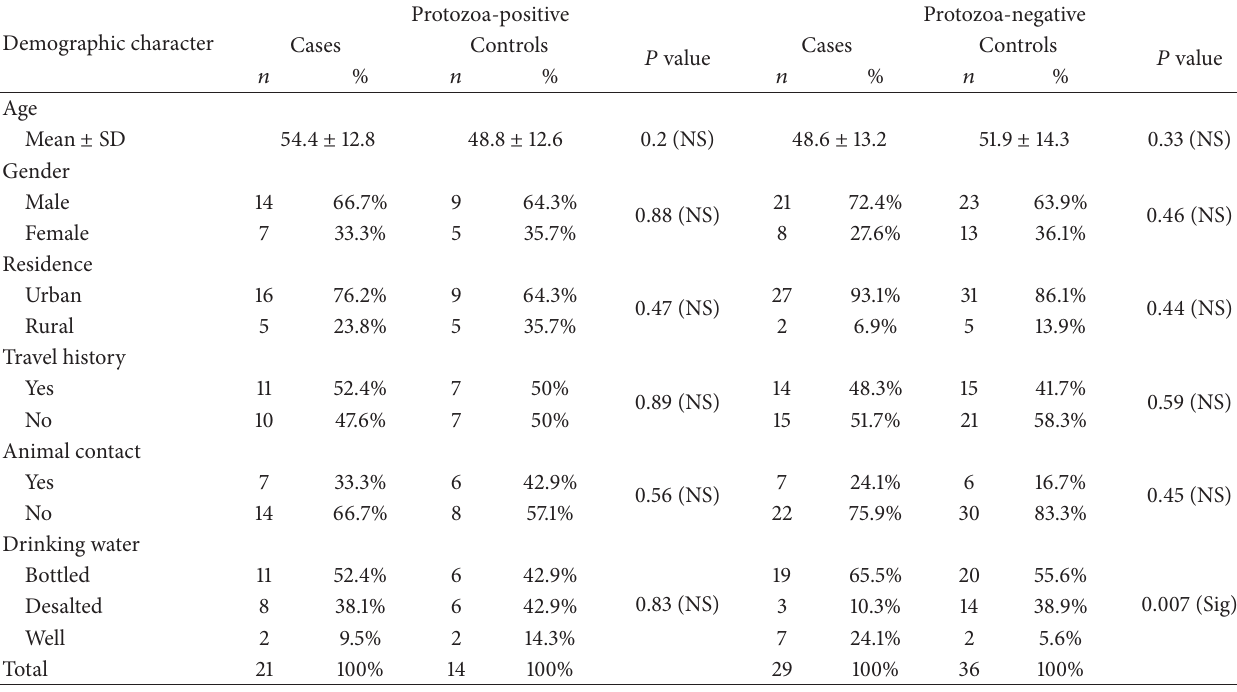
Table 1: The demographic characteristics variations among the parasitized and nonparasitized diarrheal cases and controls.